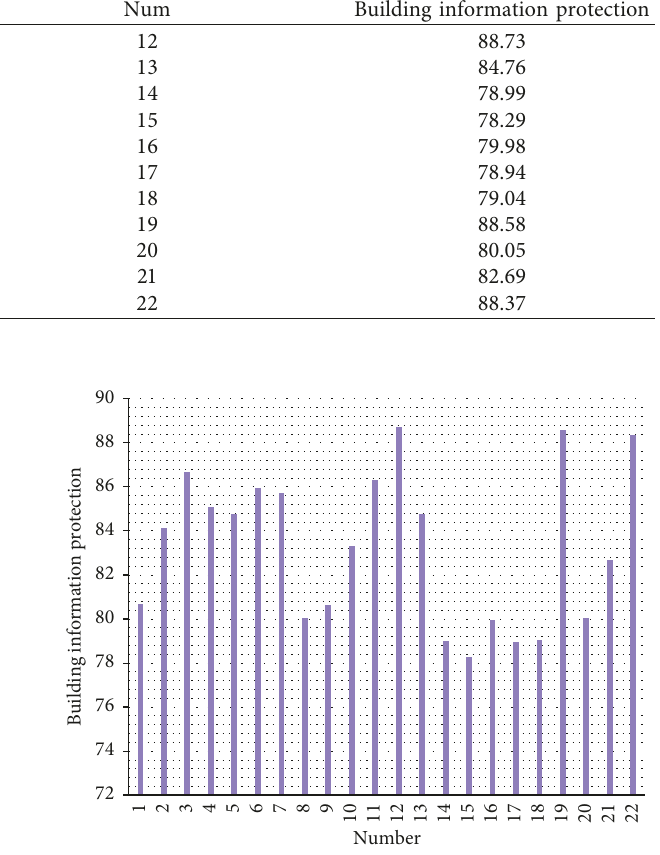
Figure 9: Statistical diagram of the evaluation of building structure construction.